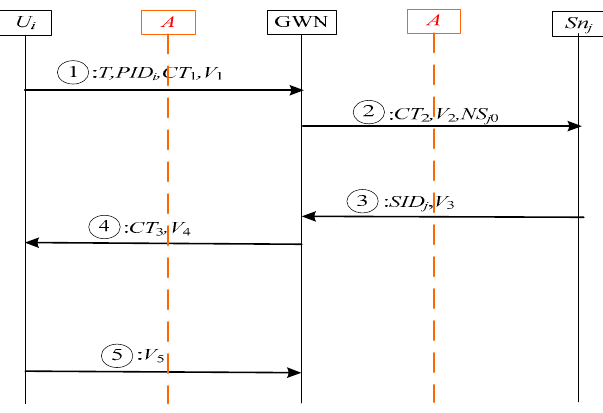
Figure 7. The de-synchronization on our proposed scheme.